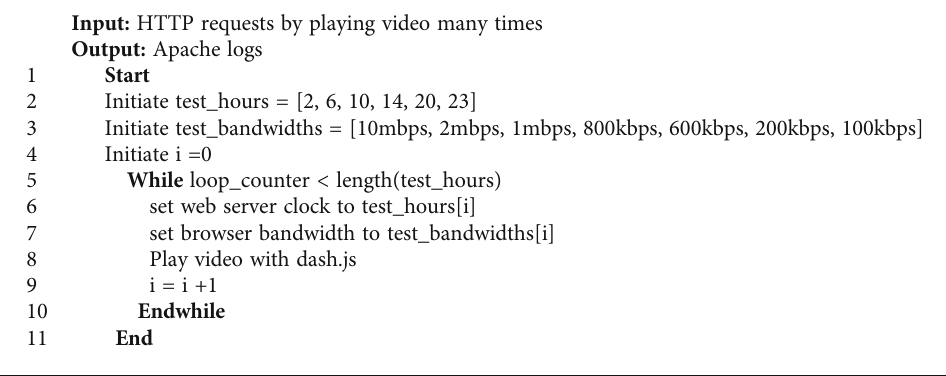
Algorithm 3: Generating Table 3: Big O time complexity of classi fi ers. Classi fi er